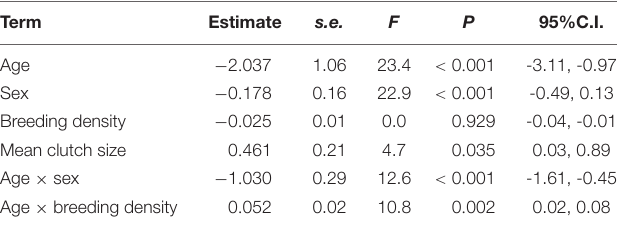
TABLE 1 | Results of GLMMs for the proportion of immigrant common kestrels as a function of age (young vs. adults), breeding density, mean clutch size of the population, the interaction between age and sex and between age and breeding density.